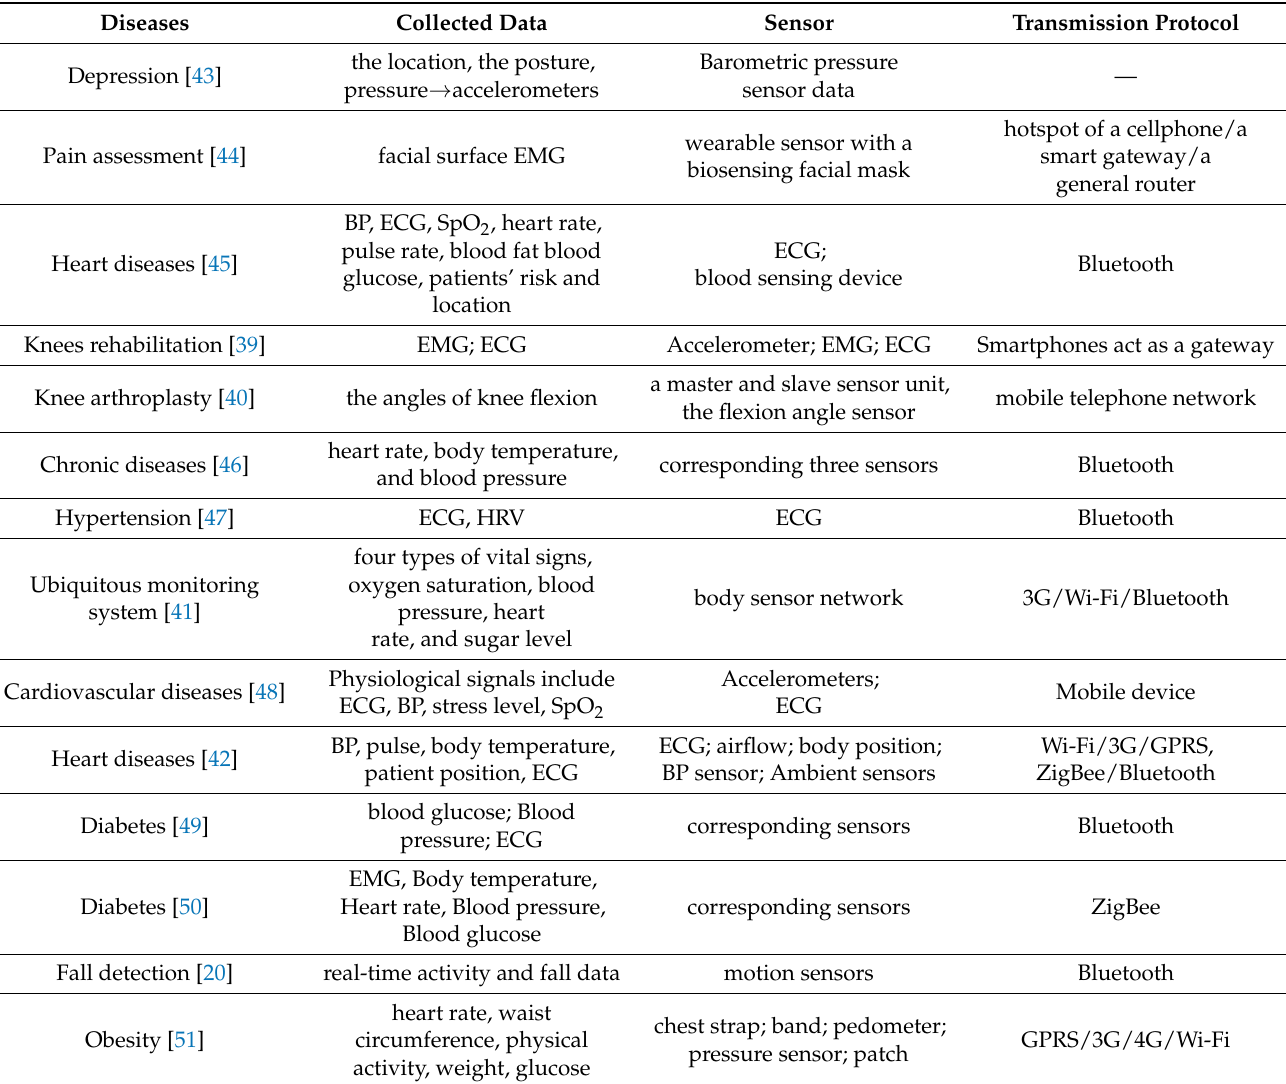
Table 2. WBAN applications for monitoring various